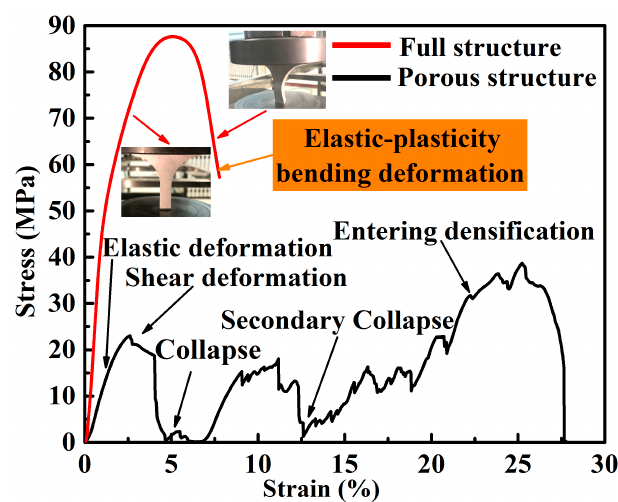
Figure 7. Compressive stress–strain curve of the tree column structures-type AlSi10Mg alloy branches.